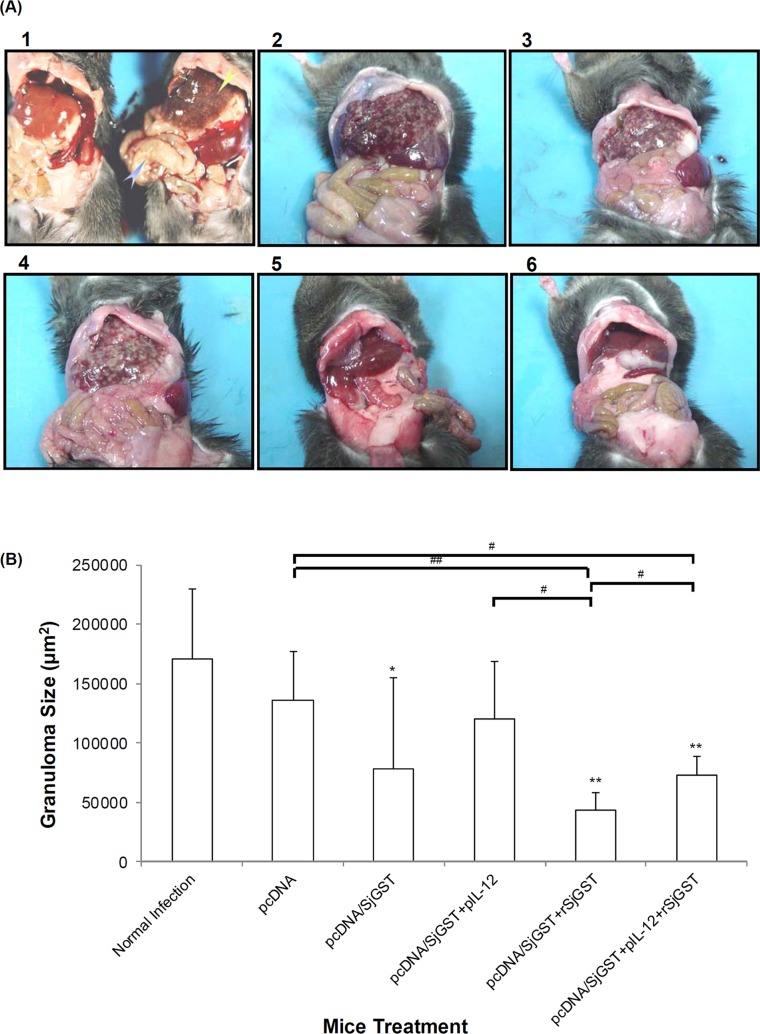
Hepatic morphology and average granuloma size in vaccinated animals challenged with Schistosoma japonicum.(A) Morphological differences were observed between livers of mice in different groups. Image 1 shows the liver and spleen of an uninfected (left) and infected (right) C57BL/6 mouse at 8 weeks. Images of Group V and VI show that vaccination with pcDNA/SjGST vaccine plus rSjGST reduced the pathological damage of egg-induced granulomas. (B) Size distribution of hepatic granulomas after vaccination with pcDNA/SjGST or addition of pIL-12 and rSjGST, followed by infection challenge. The size of each granuloma surrounding an egg was quantitated using ImageJ software (NIH). Results represent the average of 50 granulomas (mean ± SD, in μm2) from 7 animals per group. *: p < 0.05, **: p < 0.01, compared with untreated infected mice (Group I). #: p < 0.05, ##: p < 0.01 represent comparisons between the two groups indicated.